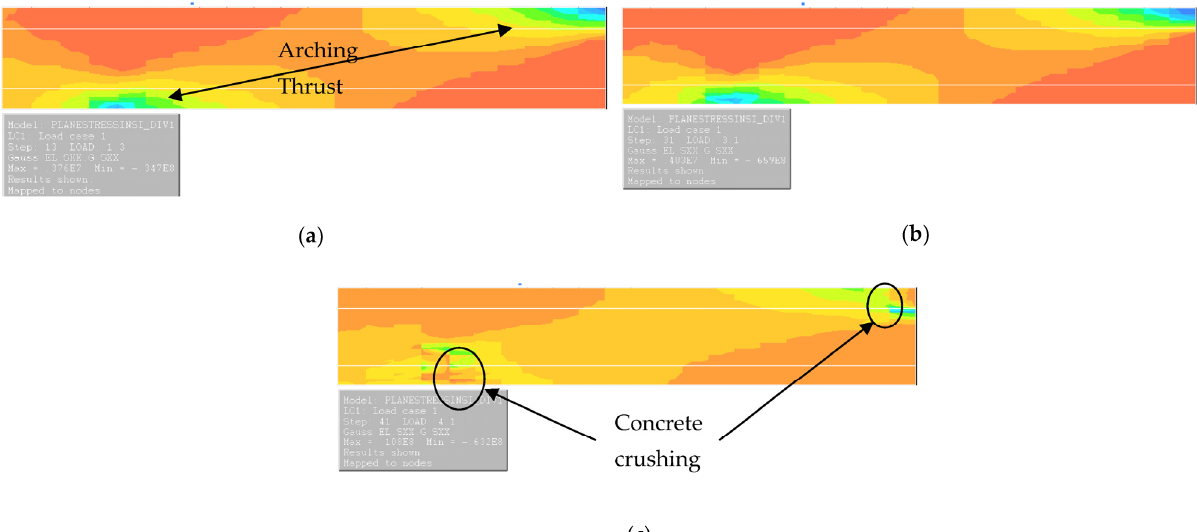
Figure 8. Stresses on a slab. ( a ) Stress distributions along the length of the slab at service load level. This figure shows only half the model of the slab. ( b ) Stress distributions along the length of the slab at the peak load. ( c ) Stress distributions along the length of the slab at the post failure